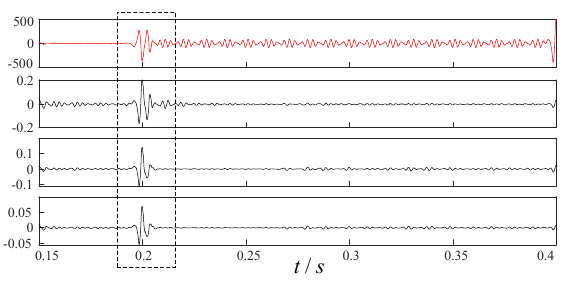
Figure 10. Waveform of wavelet packet coefficient (when the fault occurs on one line).